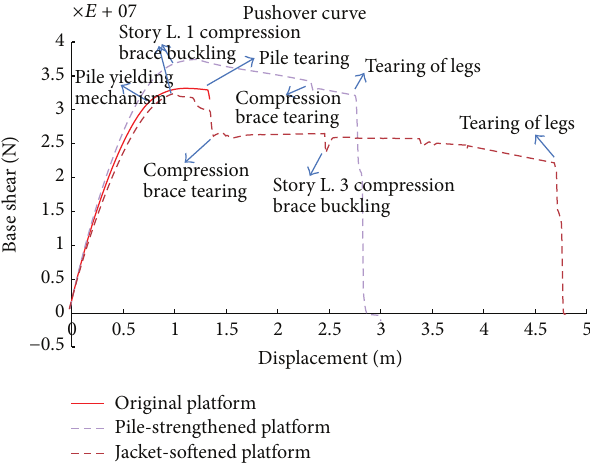
Figure 16: Sample well-head platforms pushover analysis